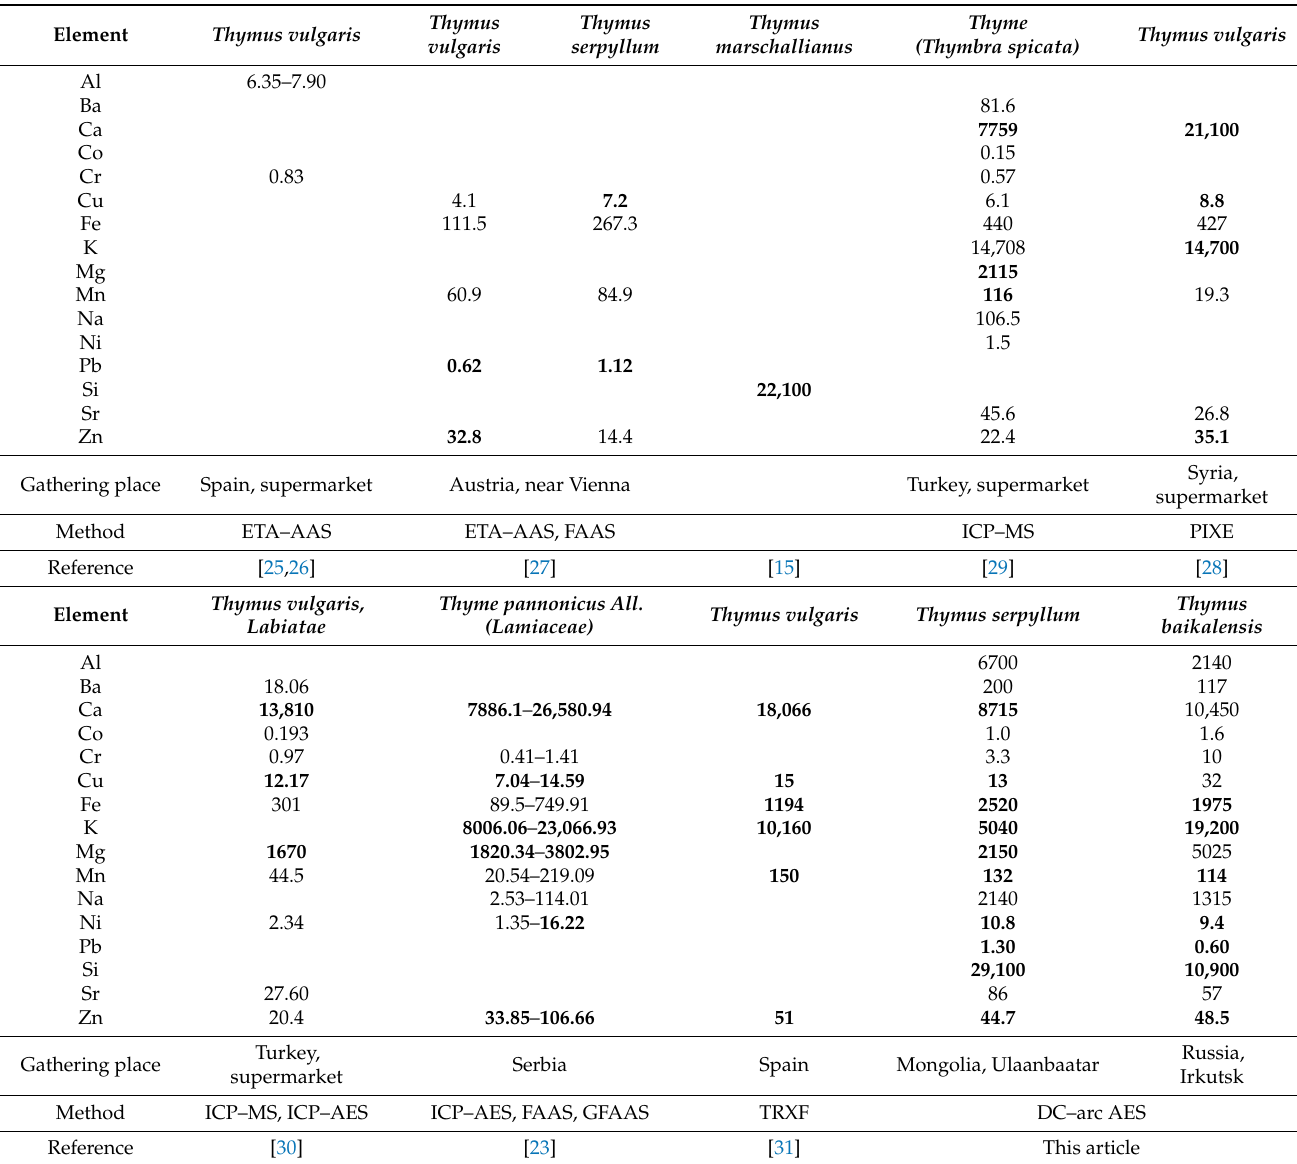
Table 2. The elemental contents (mg/kg) in the leaves and spices of the Thymus plant, found by different analytical